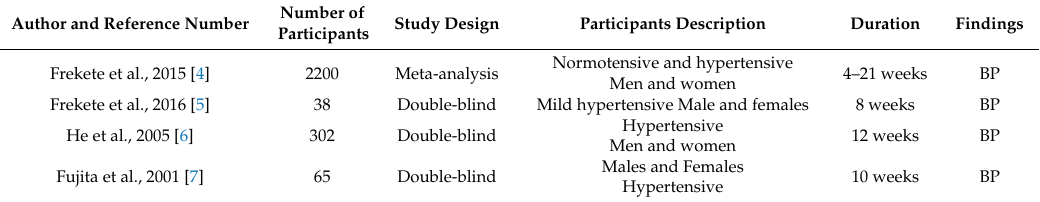
Table 8. Comparison of